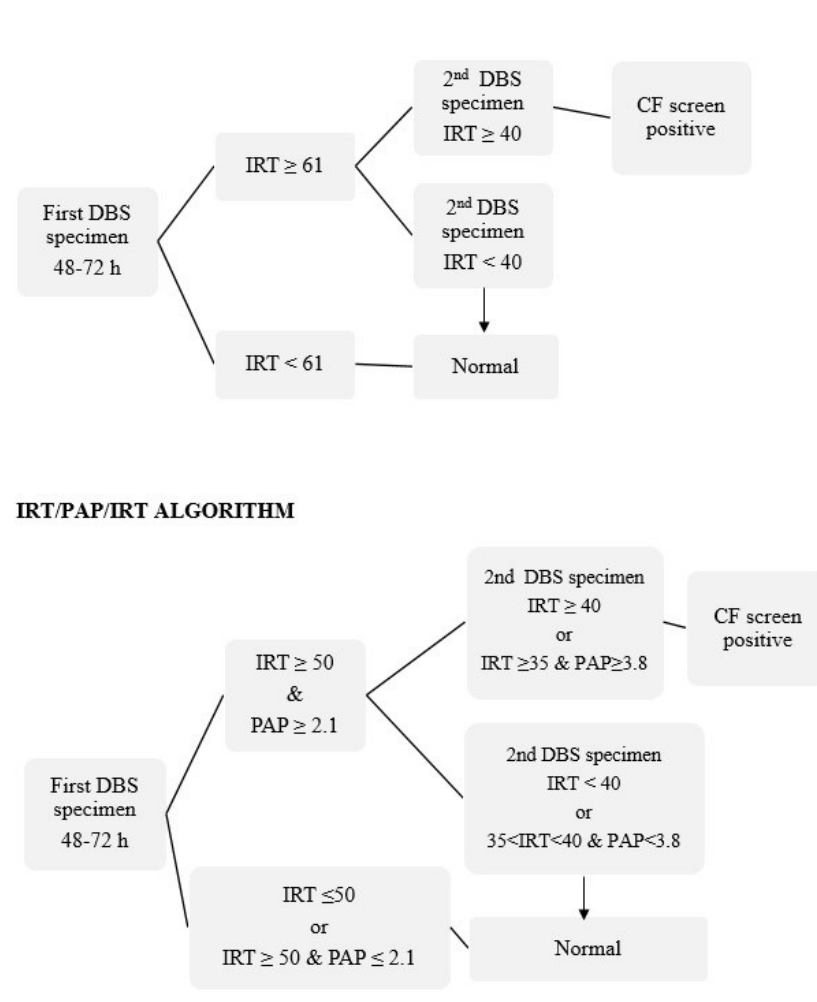
Figure 1. Algorithms used in parallel during the pilot study for cystic fibrosis newborn screening (CF-NBS) in Eastern Andalusia. Immunoreactive trypsinogen (IRT) is expressed in ng/mL and pancreatitis-associated protein (PAP) is expressed in µg/L. PAP concentration was routinely measured in the initial DBS specimen.